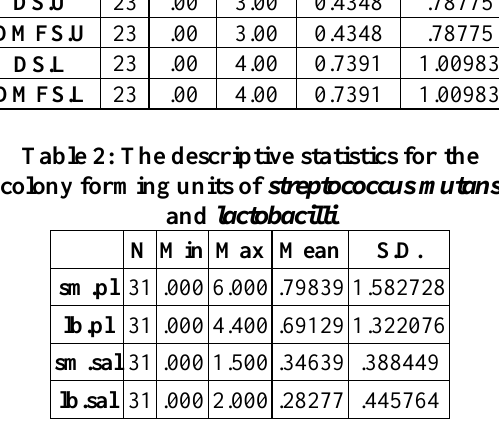
Table 3: Pearson correlation for upper primary teeth with streptococcus and lacto